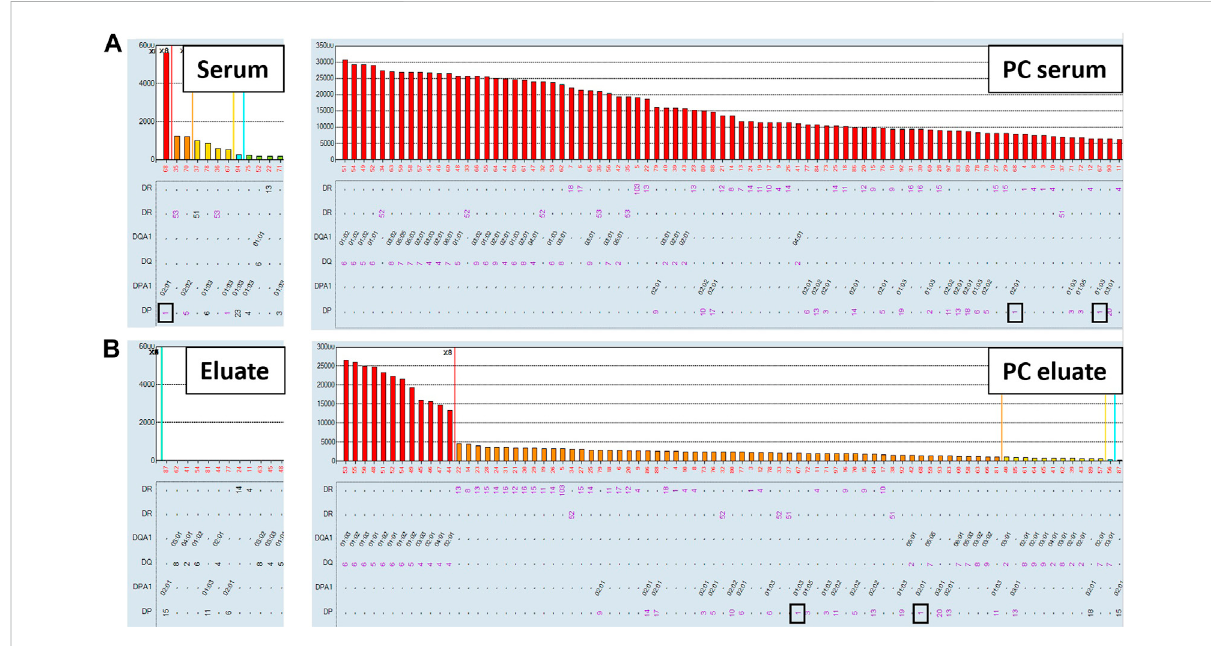
FIGURE 7 Spurious antibody reactivity targeting HLA-DP1 expressing SABs is not adsorbed/eluted with the AXE protocol. SAB images of Class II HLA speci fi cities in a patient ’ s serum (A) , (left panel) and the positive control serum (A) , (right panel), as well as AXE eluates from patient ’ s serum (B) , (left panel) and from the positive control serum (B) , (right panel) using HLA-DP1 mismatched donor cells are